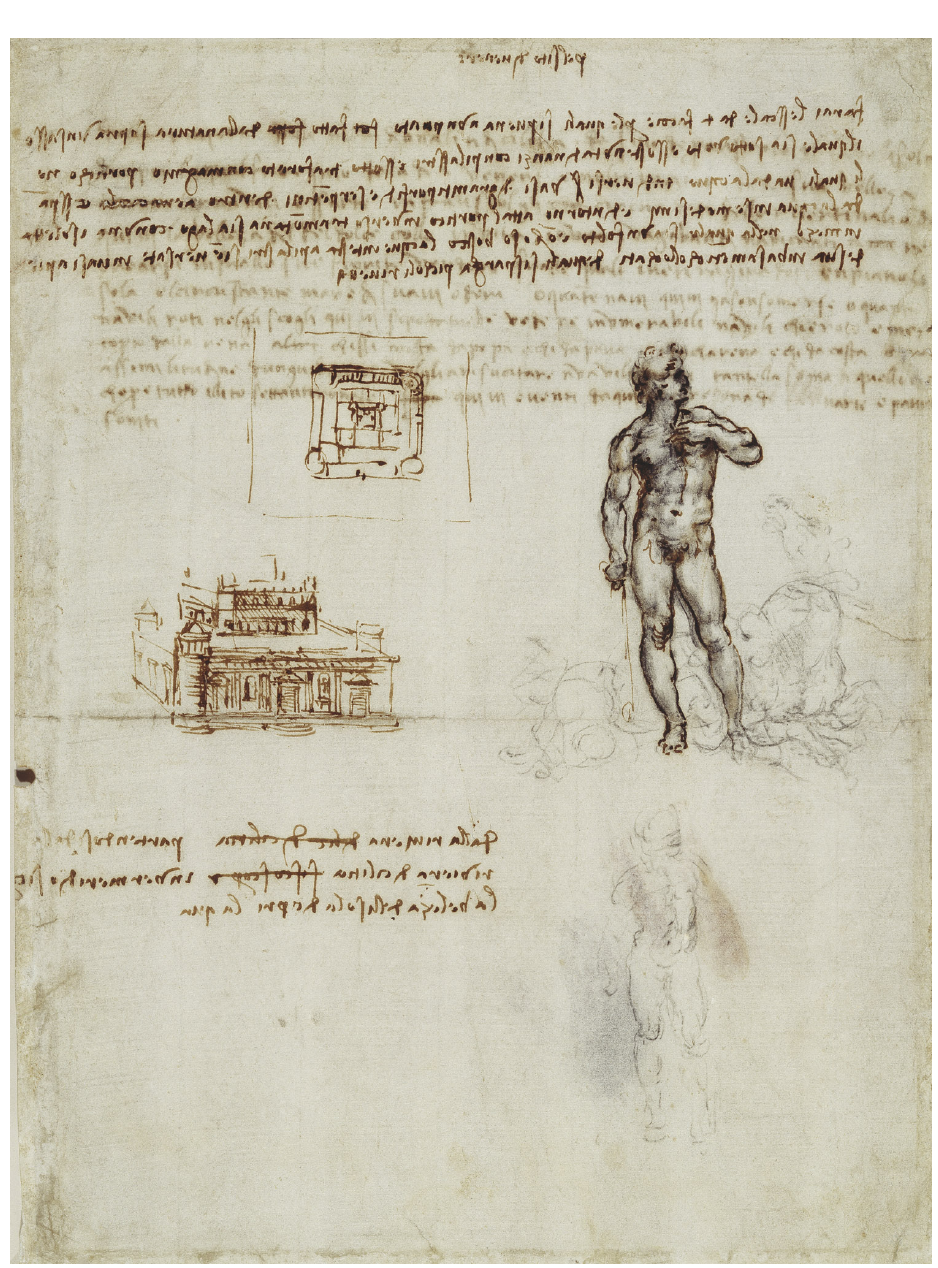
Figure 1: Leonardo da Vinci, A palazzo, and a fountain of Neptune , c. 1508-10, Black chalk, pen and ink, 27.0 x 20.1 cm (sheet of paper), RCIN 912591. Royal Collection Trust / Her Majesty Queen Elizabeth II 2019.